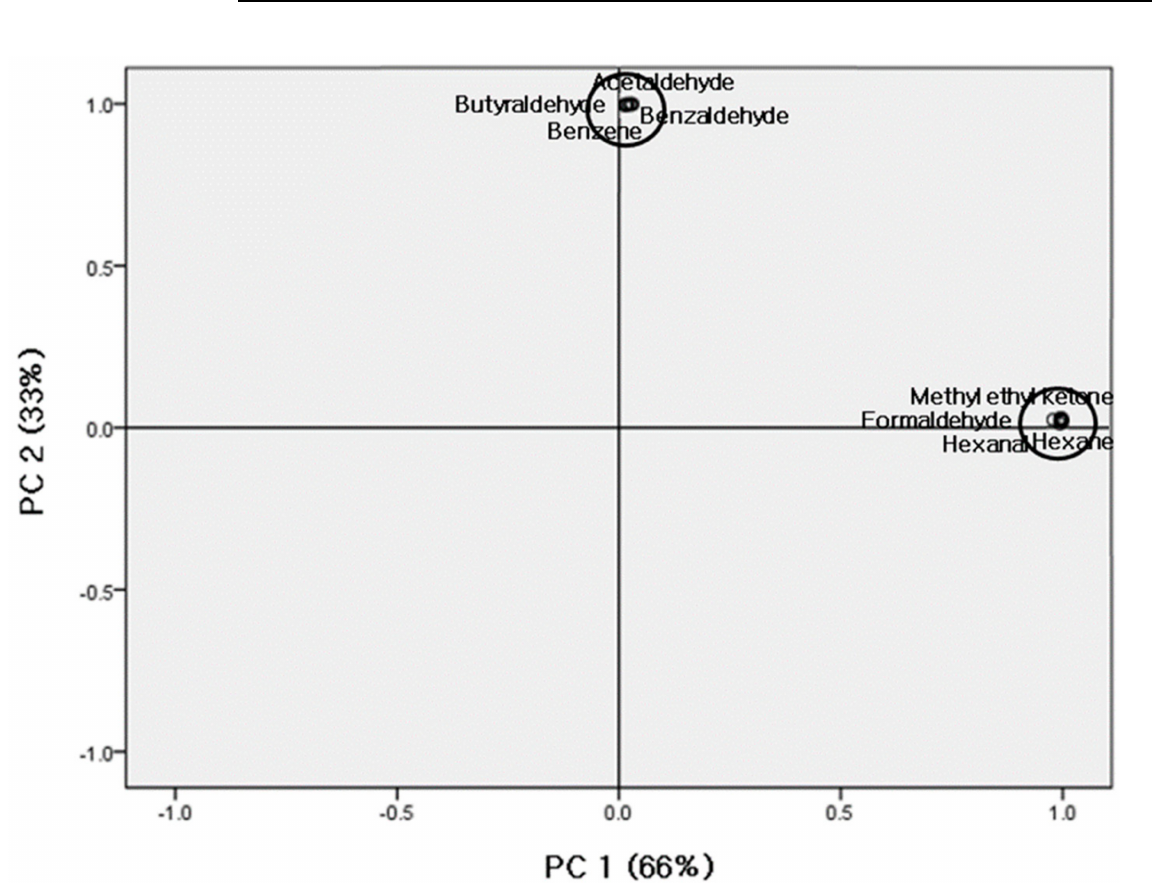
Figure 1. Principal component analysis (PCA) of data in the valuable archive